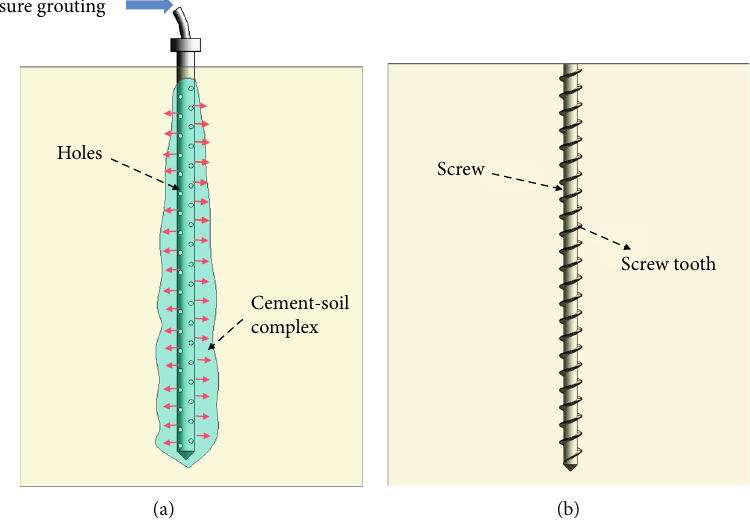
Figure 1: Schematic diagram of perforated pipe micropile (a) and screw micropile